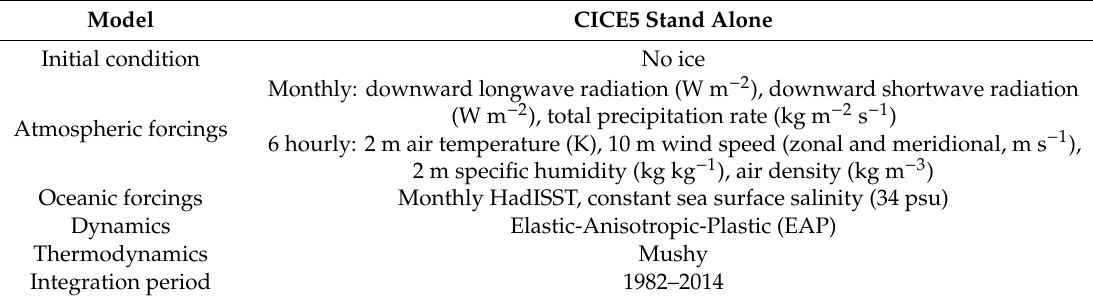
Table 1. Description of the CICE5 model